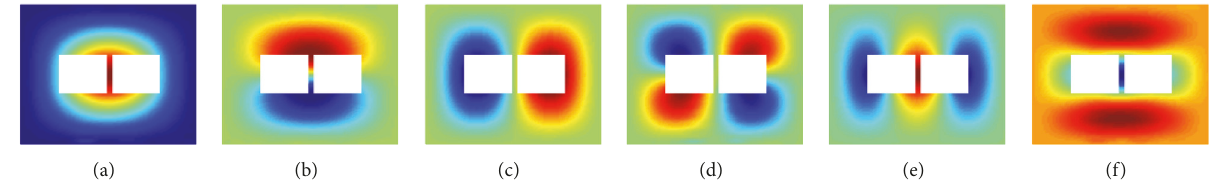
Figure 7: The first six mode shapes of the square plate with double inner cutouts. (a) The first mode; (b) the second mode; (c) the third mode; (d) the fourth mode; (e) the fifth mode; (f) the sixth mode.